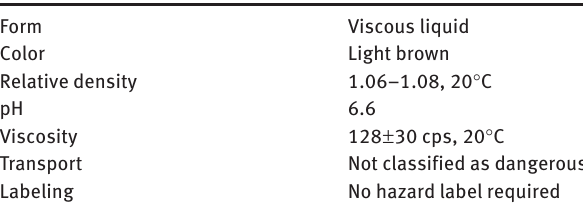
Table 4 Physical properties of poly carboxylic ether 4.